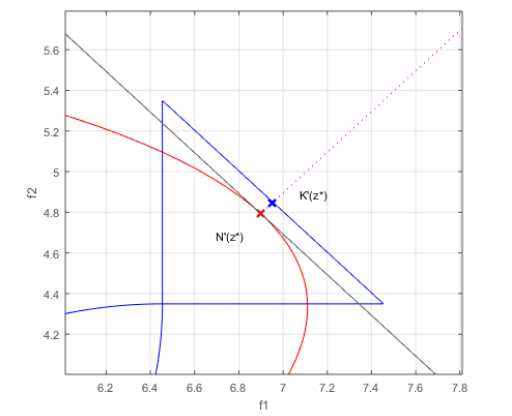
Figure 10. Super-cooperative payoff solution K (cid:48) ( z ∗ µ ) = f µ ( 1/4,1/4, z ∗ µ ) .